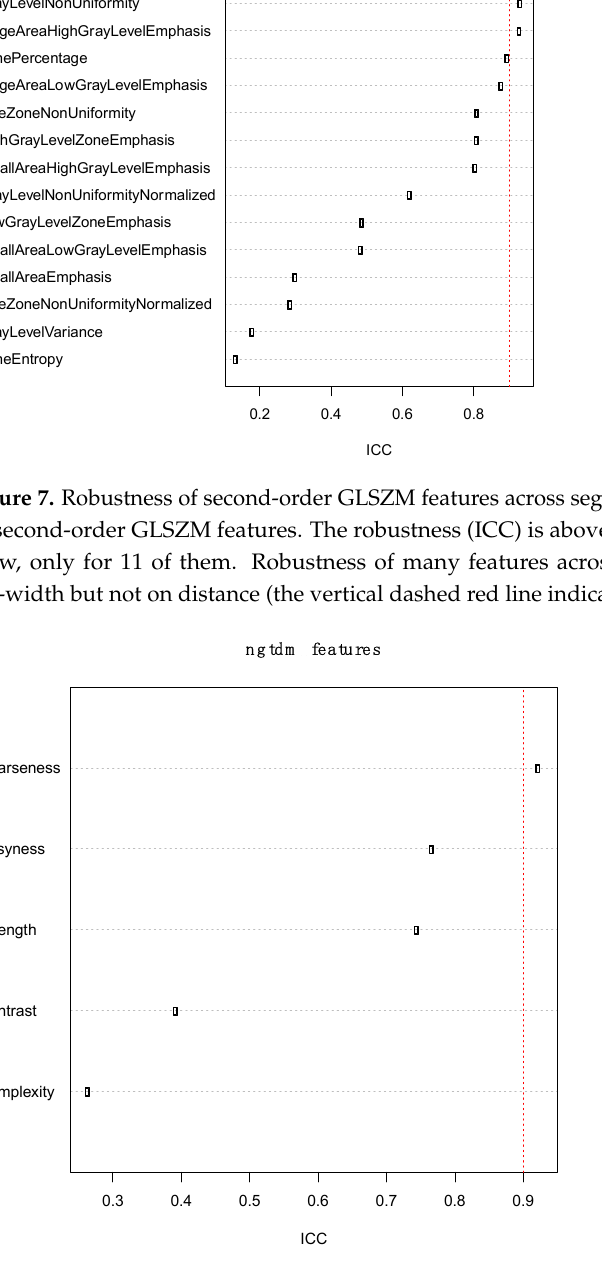
Figure 8. Robustness of second-order NGTDM features across segmentations. Pyradiomics computes five second-order NGTDM features. The robustness (ICC) is above 0.9, for all values of distance and binw, only for one of them. Robustness of many features across segmentations is dependent on bin-width but not on distance (the vertical dashed red line indicates the 0.9 threshold).